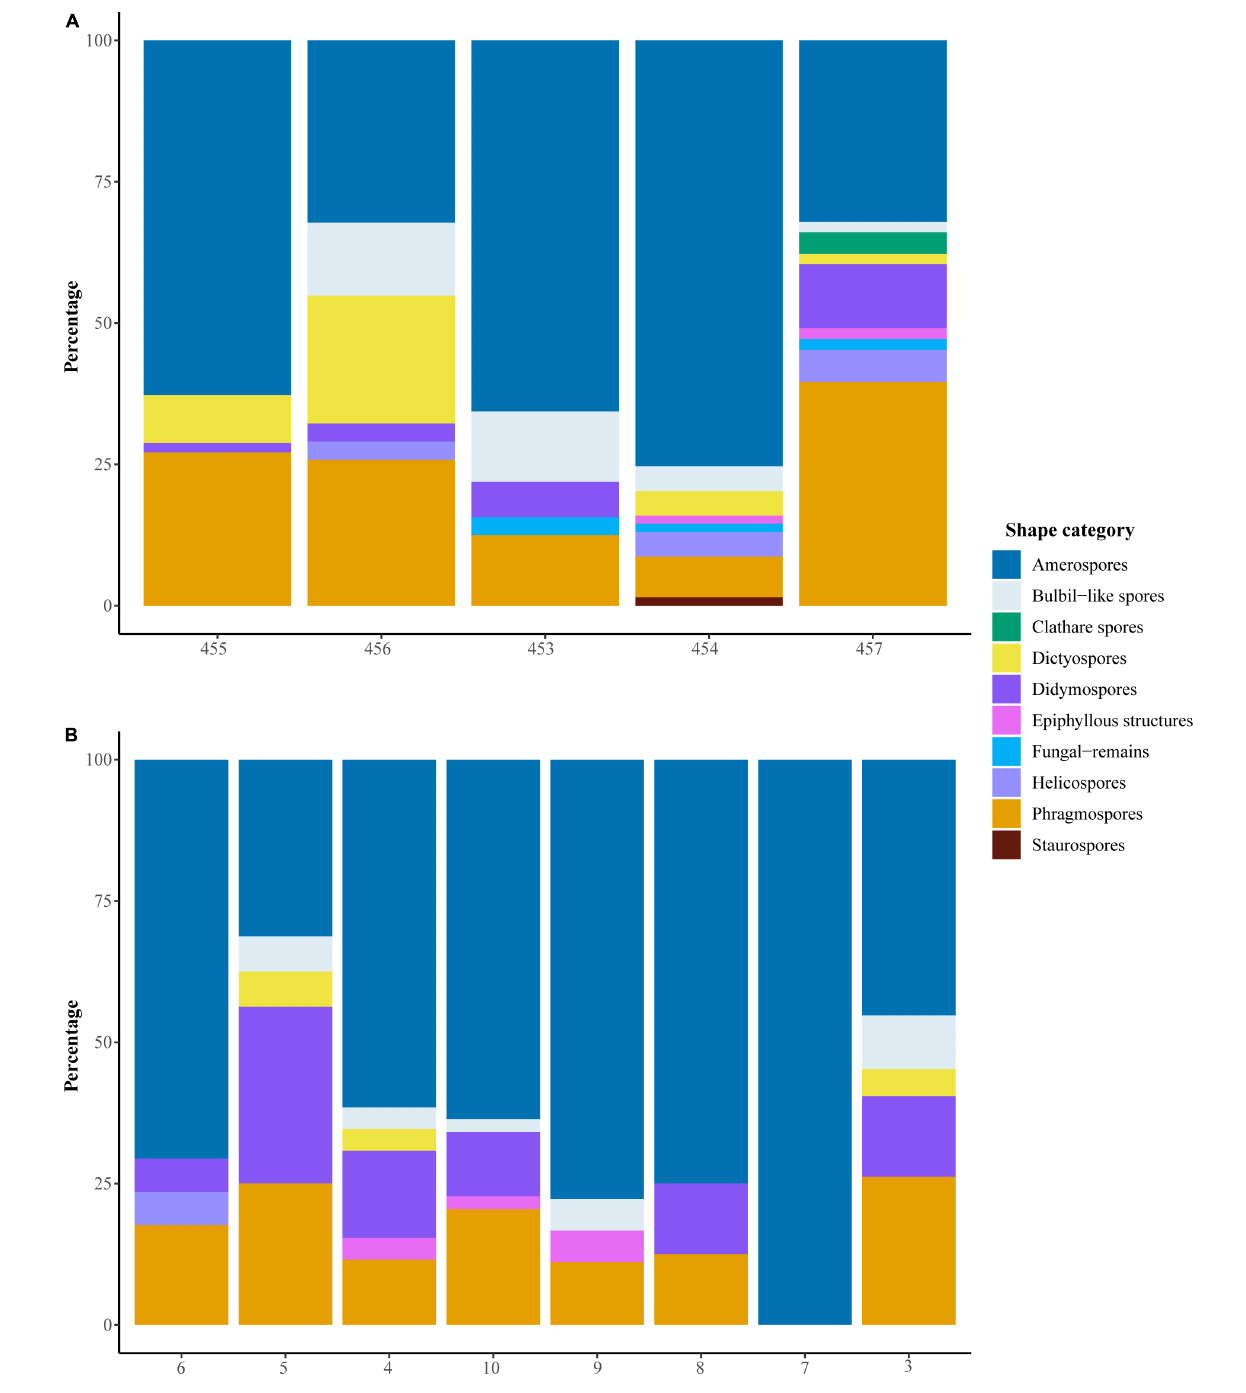
FIGURE 7 | Bar plots show the percentage of each morphological group per sample. The samples are organized in chronological order from young (left) to old (right), refer to Figure 2 . (A) Samples from Thailand, (B) Samples from Slovakia.